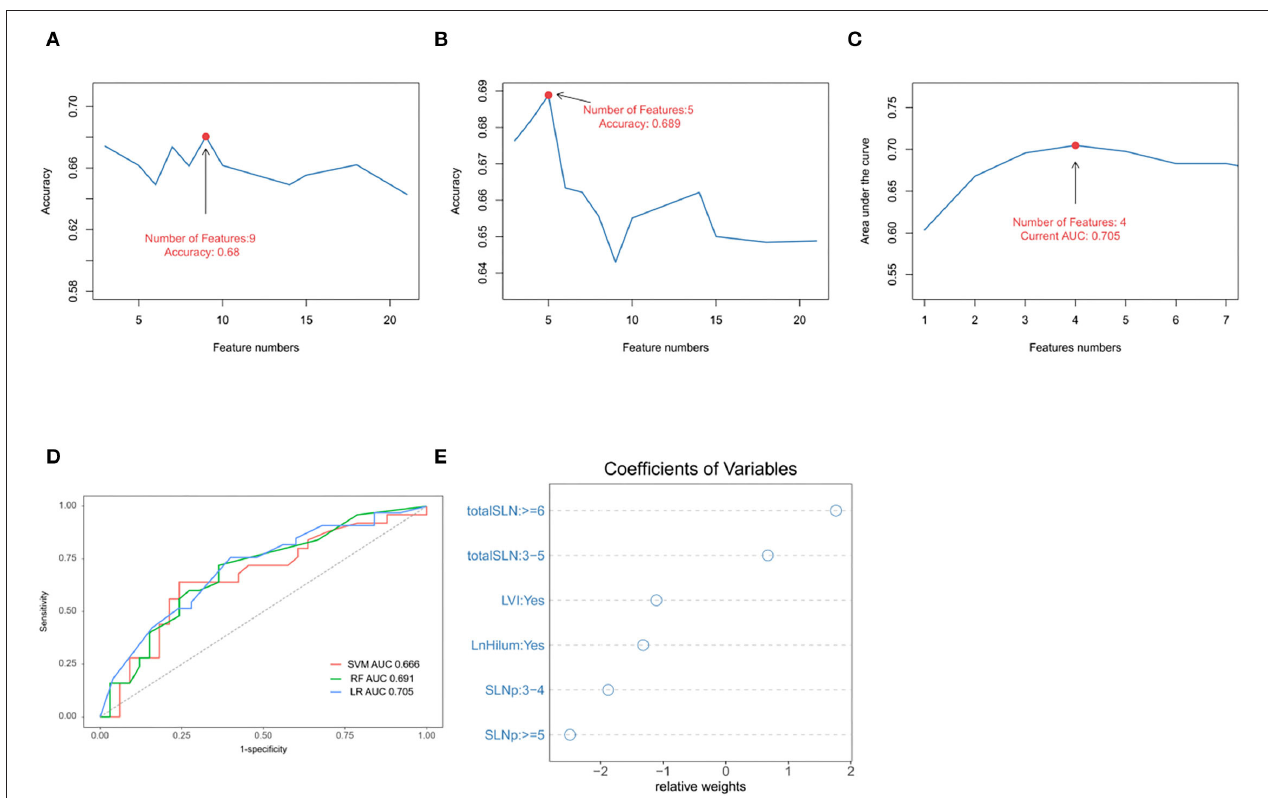
FIGURE 2 | Predictive model and factors selection. (A) The line graph shows the relationship between the number of candidate features and the accuracy in support vector machines (SVMs) model. (B) The line graph shows the relationship between the number of selected features and the accuracy in random forest (RF) model. (C) The line graph shows the relationship between the number of features and the area under the curve (AUC) values in the least absolute shrinkage and selection operator (LASSO)-based logistical model. (D) ROC curve analysis of machine-learning algorithms for prediction of non-sentinel lymph nodes (NSLN) without metastasis in the validation set. (E) The dot plot shows the coefficients of variables in the final model. LVI: lymphovascular invasion; totalSLN: total number of SLNs harvested; LnHilum: absence of lymph node hilum; SLNp: number of positive